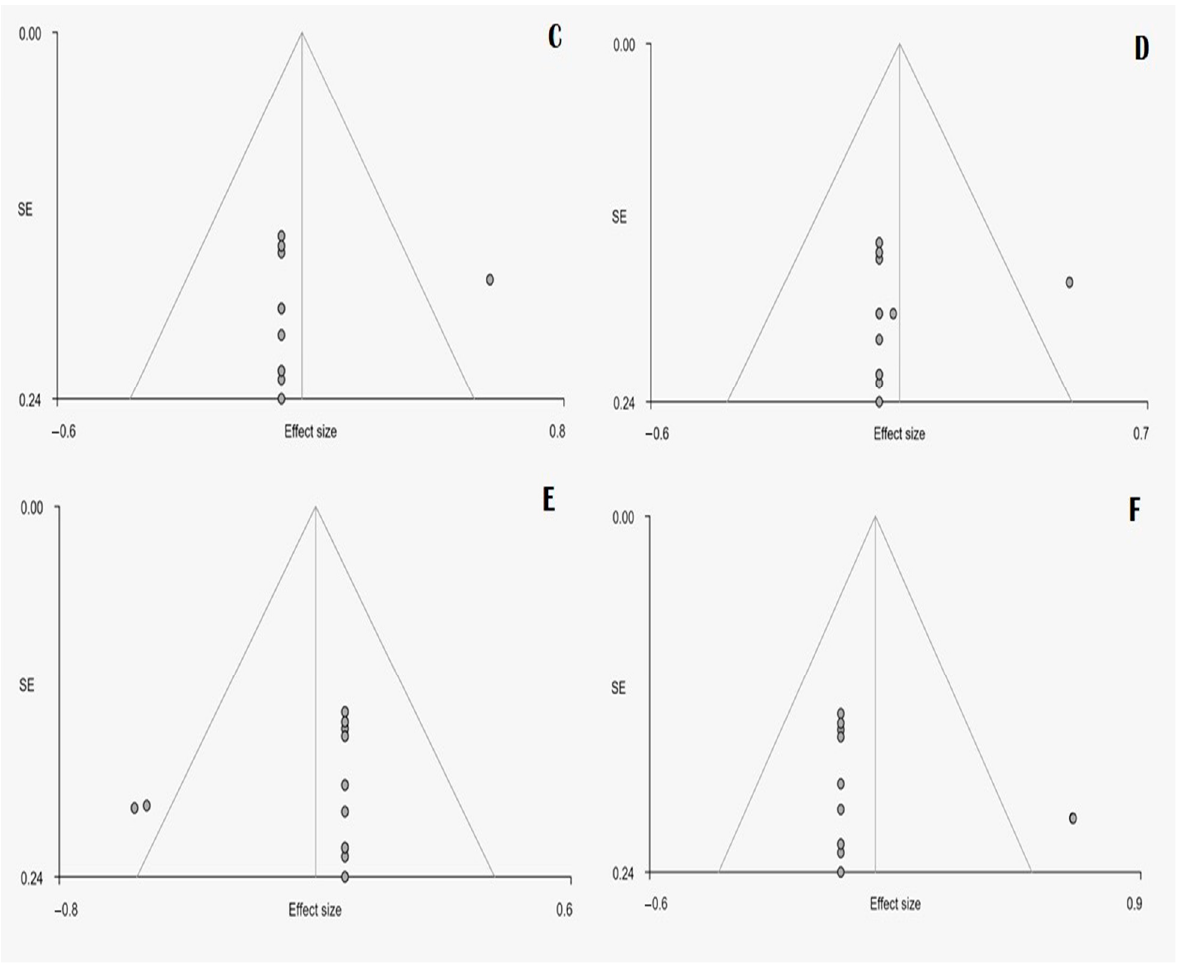
Figure 3. Funnel plot diagrams on all the areas that showed statistically significant differences between JME patients and controls. ( A ) Thalamus, ( B ) Left median cingulate cortex, ( C ) Left precentral gyrus, ( D ) Left supplementary motor area, ( E ) Right Insula, ( F ) Right superior frontal gyrus.